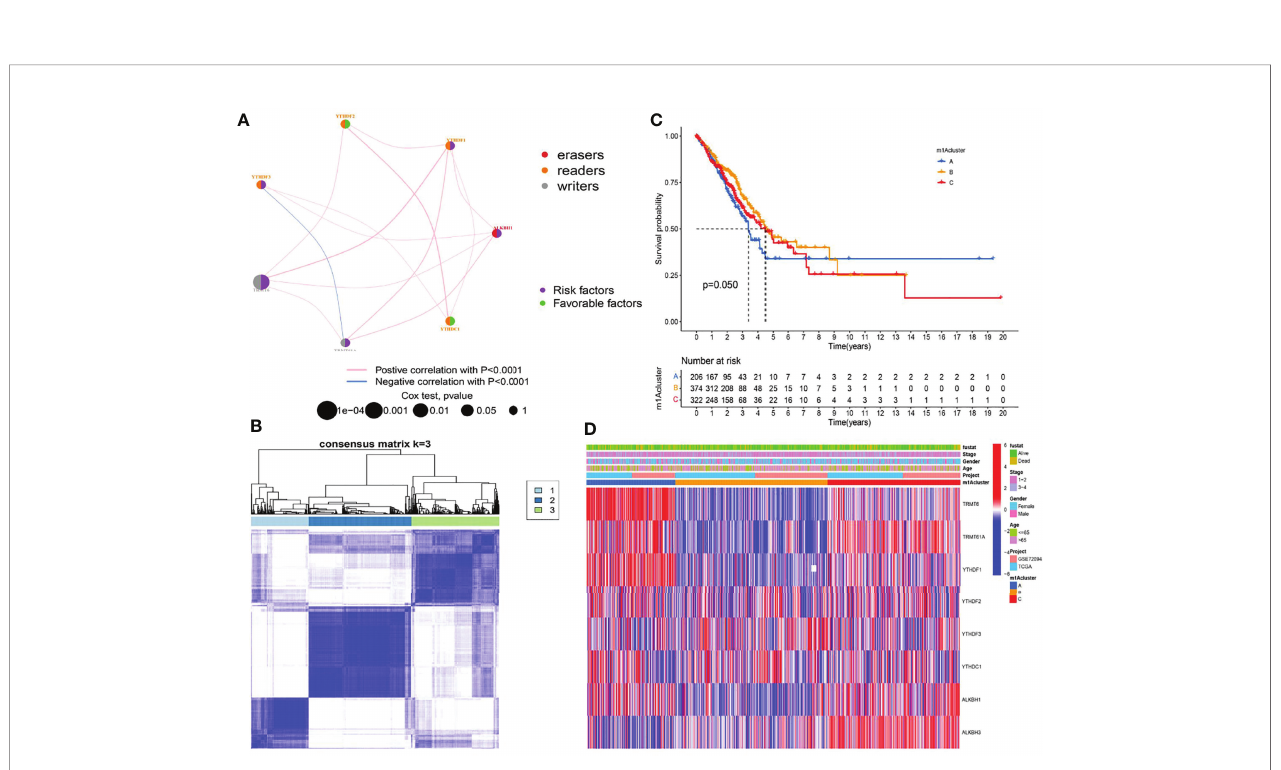
FIGURE 2 | Establishment of three m1A modi fi cation patterns. (A) The correlation of nine m1A regulators in LUAD. (B) Consensus clustering of m1A clusters for LUAD patients in the training cohort. (C) Differences in survival outcomes of three m1A clusters in the training cohort. (D) Heatmap of three m1A modi fi cation patterns in the training cohort.